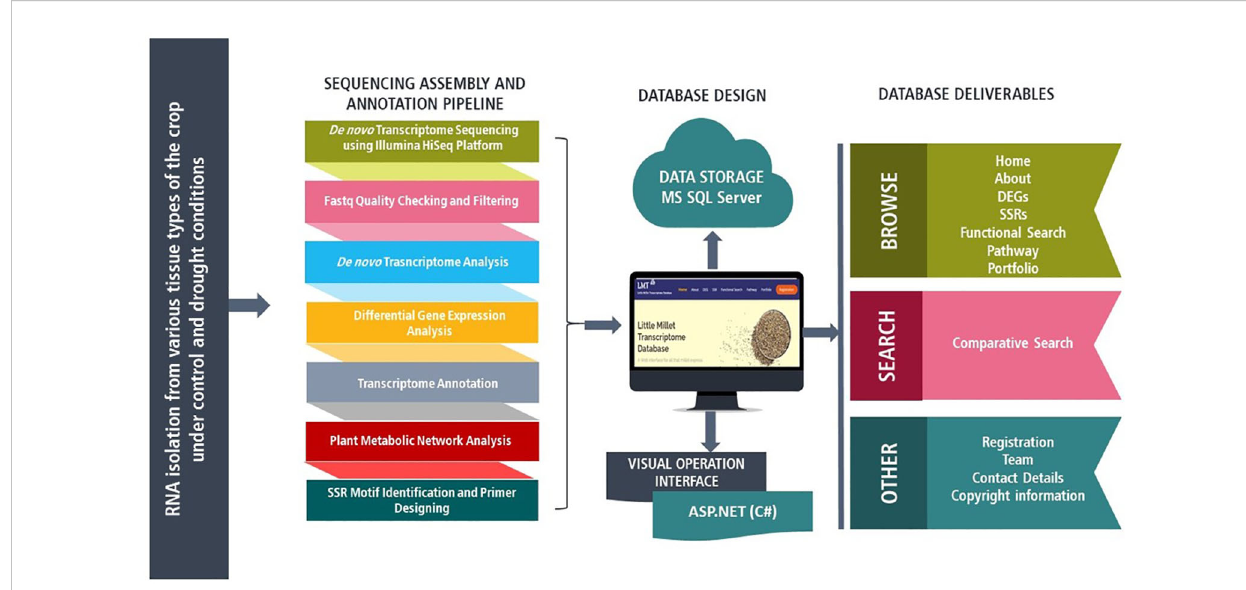
FIGURE 1 Schematics of Little Millet transcriptome database (LMT db v.1.0.0) structure and web interface features along with transcriptome sequencing, assembly, and annotation